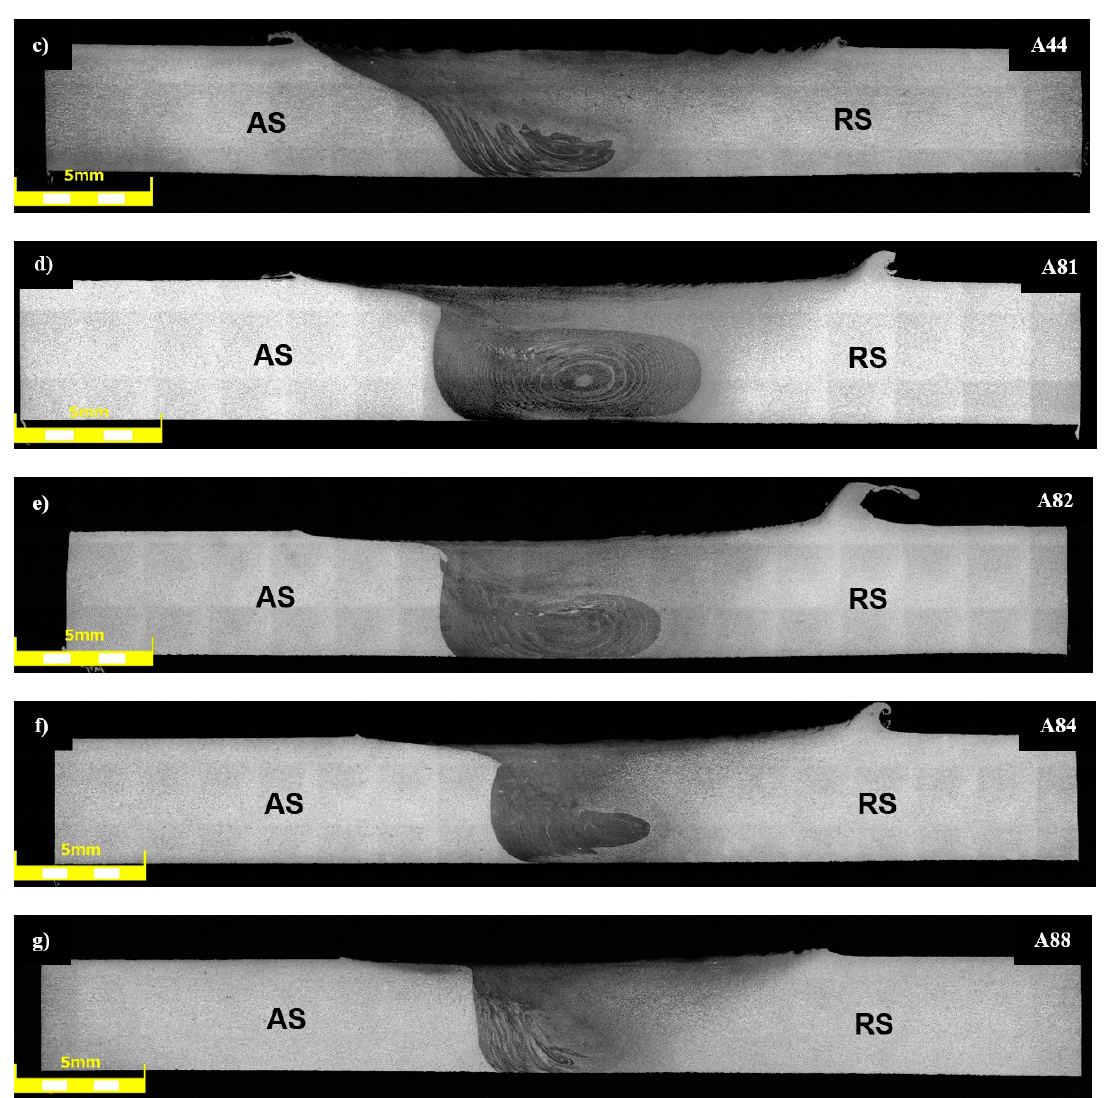
Figure 2. Light microscopy images of the 2519 friction stir welding (FSW) joint: ( a ) A41, ( b ) A42, ( c ) A44, ( d ) A81, ( e ) A82, ( f ) A84, ( g ) A88. AS—advancing side, RS—retreating side.